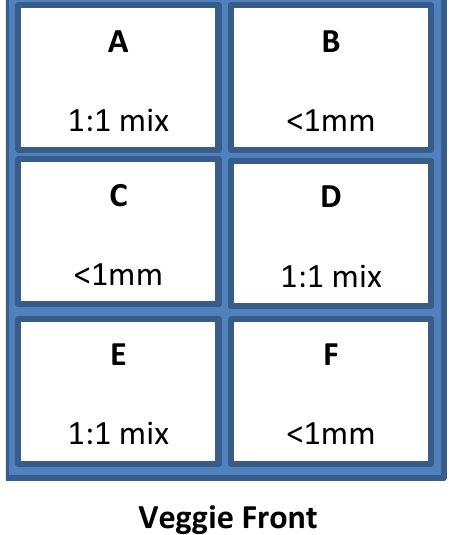
Figure 2. Plant pillow layout inside of the Veggie hardware. Map shows pillows labeled A-F as well as the substrate composition inside each